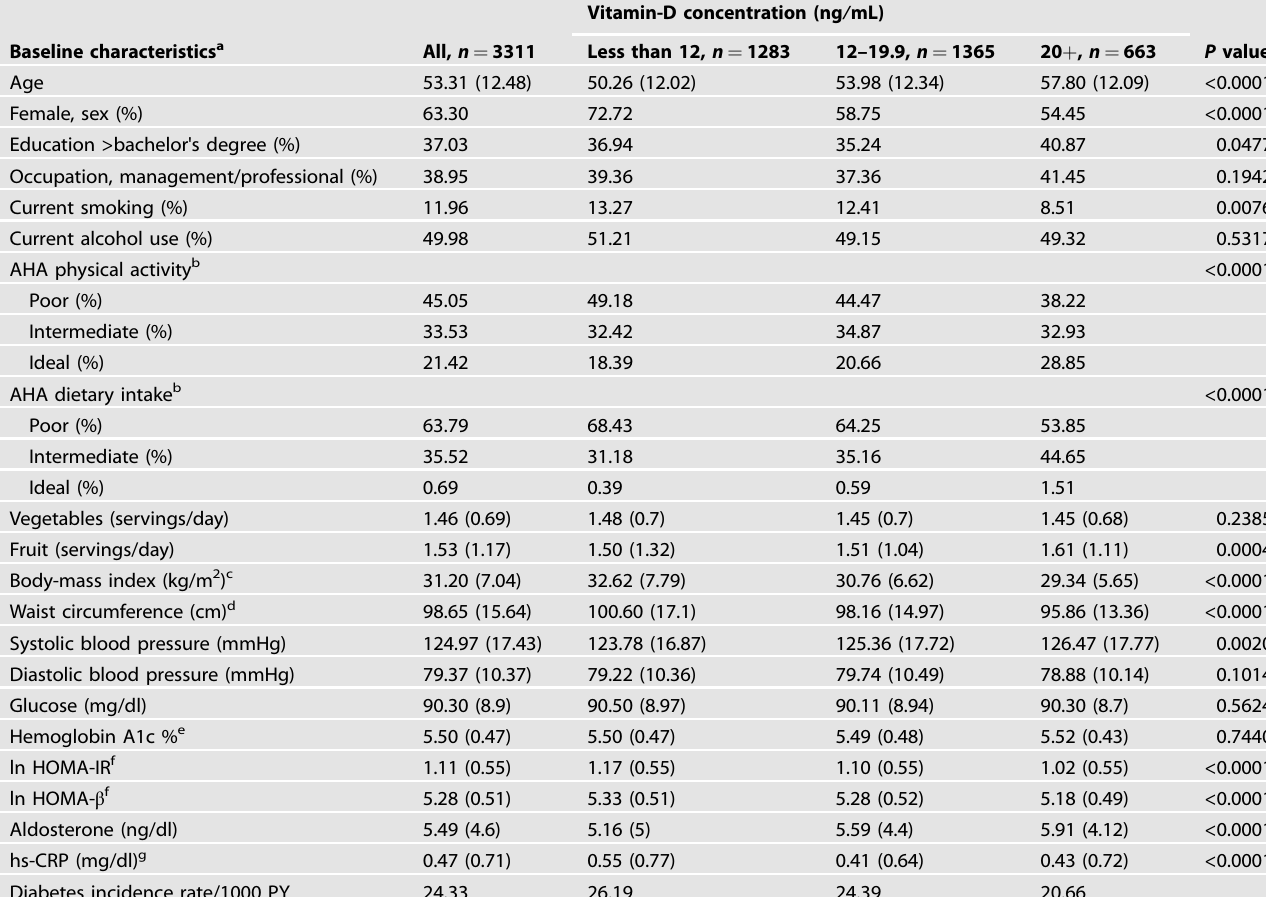
Table 1. Baseline characteristics of Jackson Heart Study Participants by 25(OH) vitamin-D categories (Institute of Medicine). Vitamin-D concentration (ng ⁄